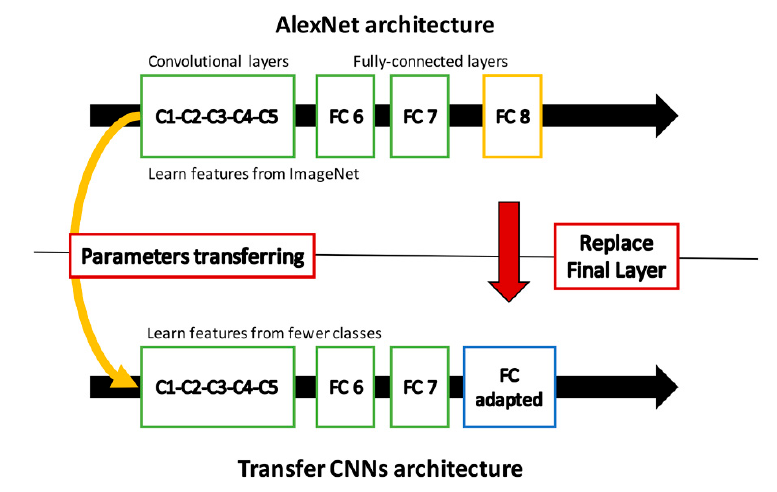
Figure 3. Parameter transfer in the proposed deep convolutional neural network.